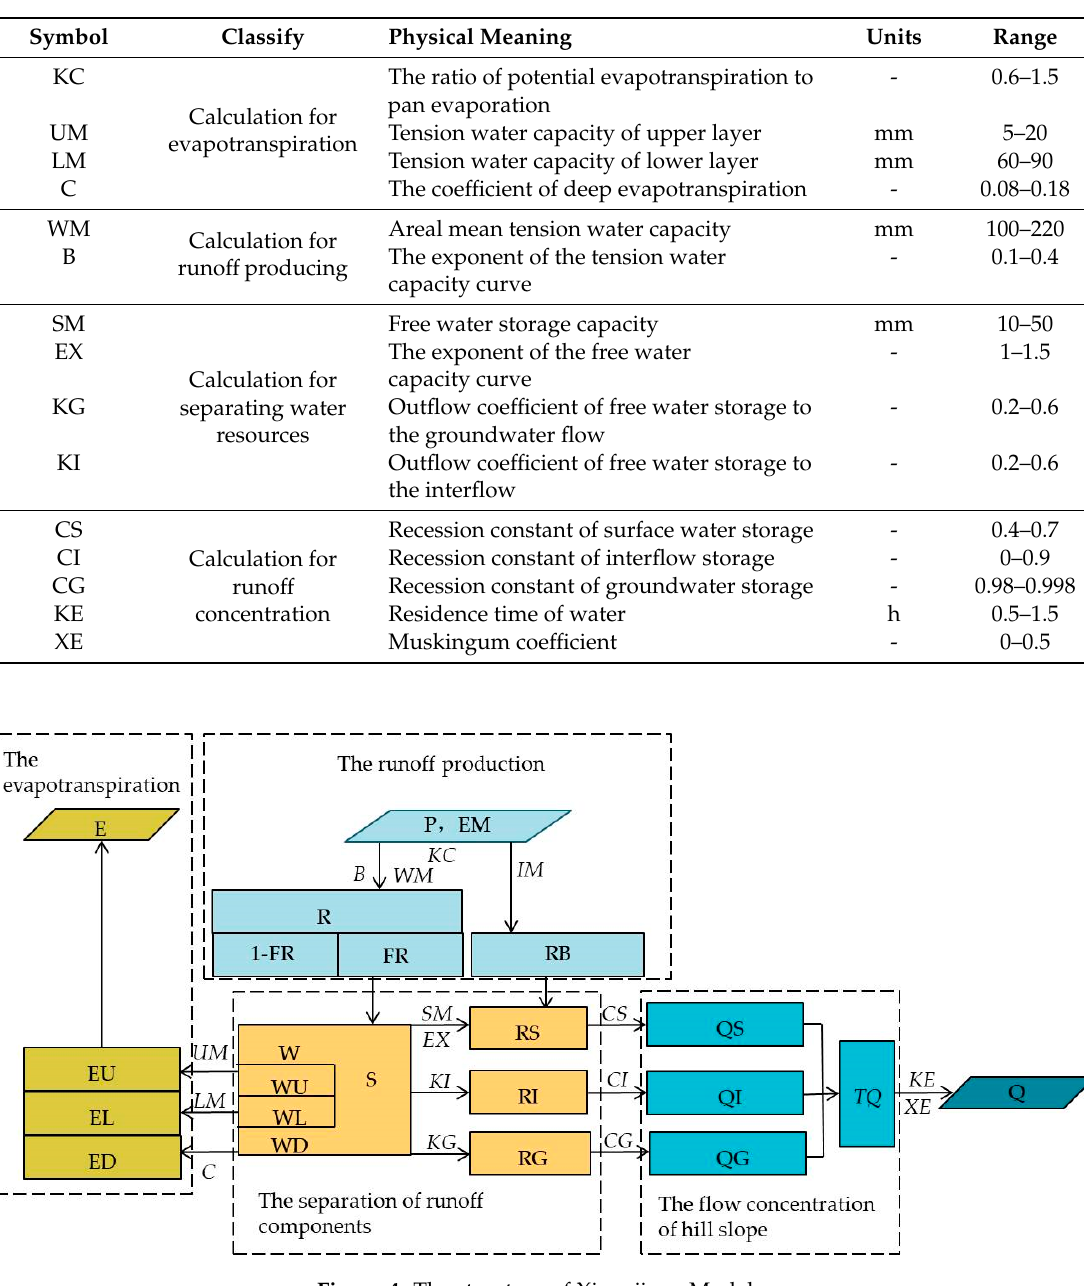
Figure 4. The structure of Xinanjiang Model.